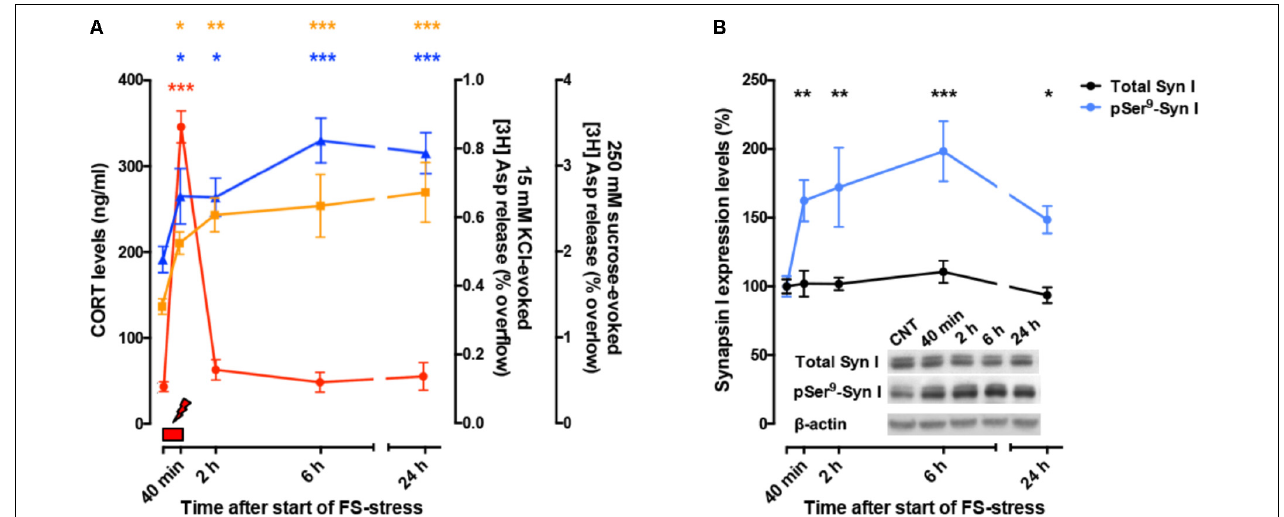
FIGURE 3 | (A) Time course of CORT serum levels (red), 15 mM KCl-evoked [3H]D-Asp overflow (blue), and 250 mM sucrose-evoked [3H]D-Asp overflow (yellow) from superfused PFC/FC synaptosomes, after acute FS stress. The net depolarization-evoked overflow was calculated by subtracting transmitter content of the basal outflow. 15 mM KCl-evoked overflow is a measure of depolarization-evoked glutamate release; 250 mM sucrose-evoked overflow is a measure of RRP. The timing of actual FS stress (40 min) is indicated by the red mark. (B) Time course of total synapsin I expression and phospho-Ser 9 (site 1) levels in synaptic membranes from PFC/FC after acute FS stress. Data are expressed as mean ± s.e.m. Insets: representative immunoreactive bands. (A,B) Modified from Musazzi et al.